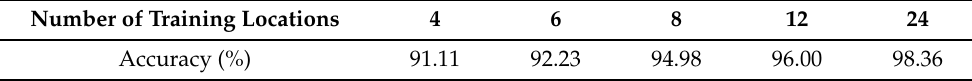
Table 4. The average recognition accuracy for different numbers of training locations.